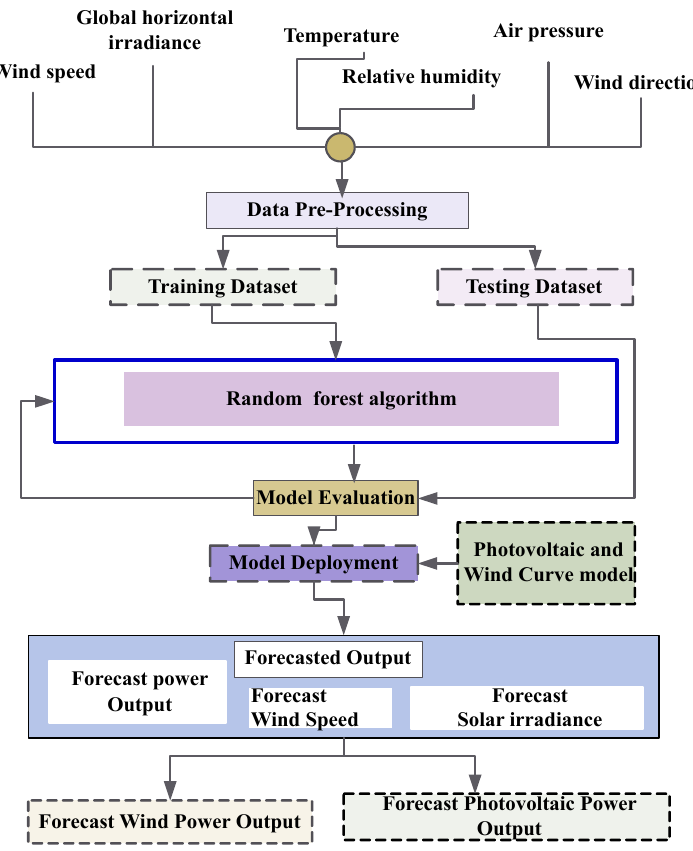
Figure 3. Proposed schematic forecasting